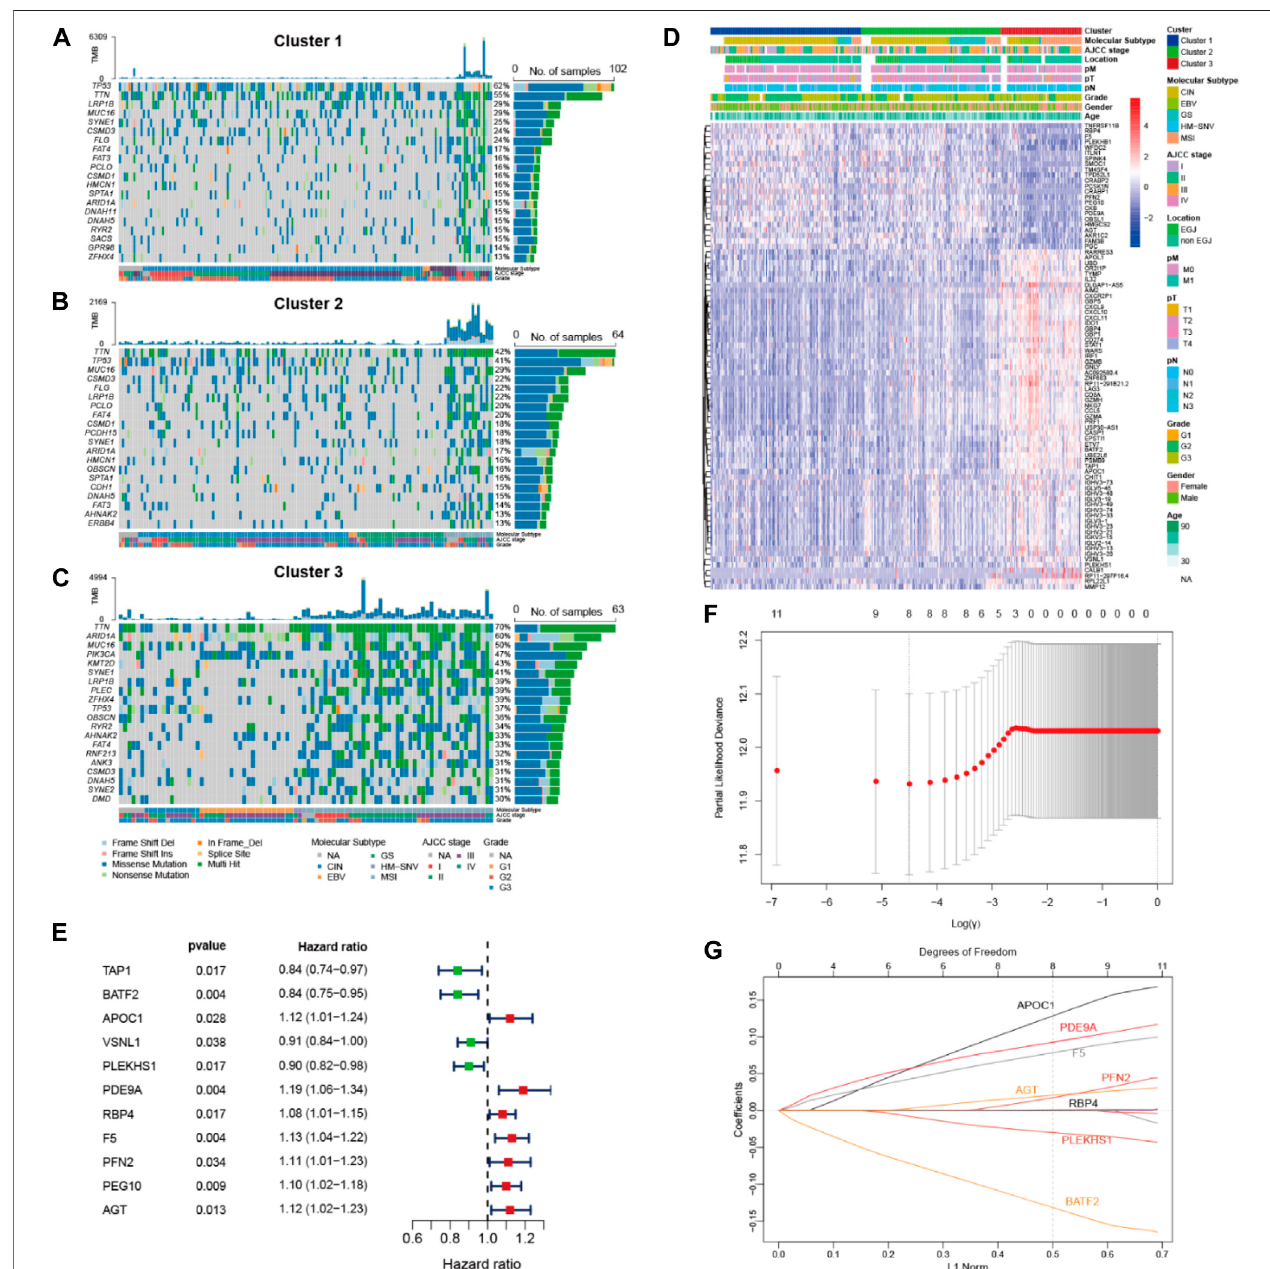
FIGURE2| Genomic analysisofpyroptosisclustersandconstructionofpyroptosisriskscores. (A,B,C) Top20mostfrequentlymutatedgenesofthe3pyroptosis clusters. (D) Heatmap showing the correlations between pyroptosis clusters and DEGs, among which 62 genes and 23 genes were up- and down-regulated in pyroptosiscluster3,respectively. (E) ForestplotofHRsfor11DEGs. (F) Partiallikelihooddevianceof11DEGsidenti fi edbytheLASSOregressionmodel,inwhich1000- fold cross-validation was used for variables selection. (G) LASSO coef fi cients of DEGs, each curve represents a gene. DEGs, differential expression genes; HRs, hazard